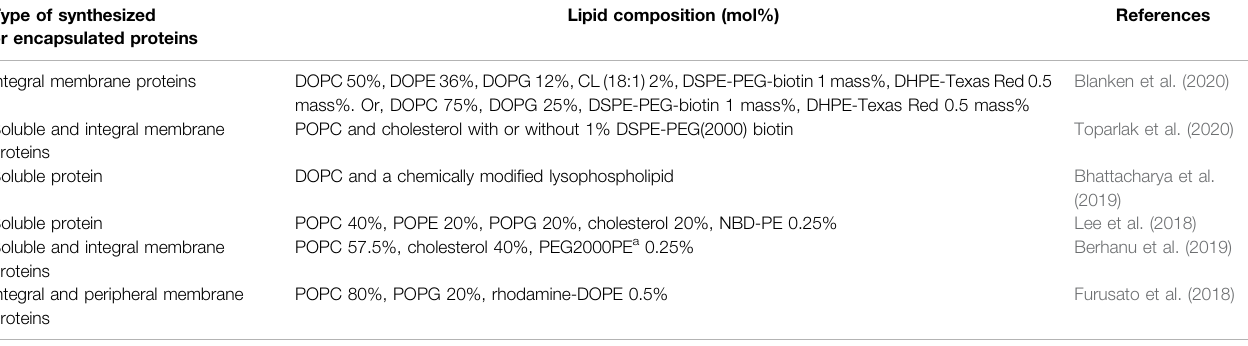
TABLE 1 | Lipid composition of GV used for arti fi cial cell experiments. Type of synthesized or encapsulated proteins